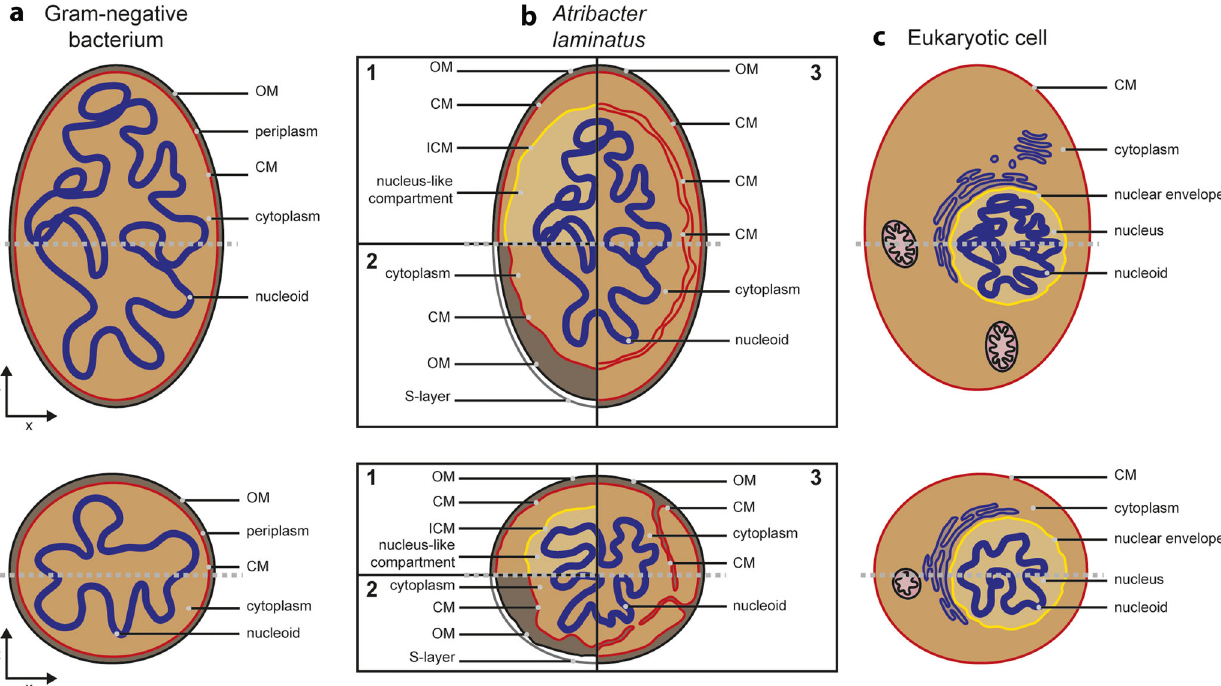
Fig. 1 Alternative interpretations of the cell biology of Atribacter laminatus . Comparison of the cell plans of a typical Gram-negative bacterium ( a ), Atribacter laminatus ( b ), and a typical eukaryotic cell ( c ), displayed both in the xy-plane (top row) and the xz-plane (bottom row). The gray dashed lines indicate the plane illustrated in the other orientation. Shown are three possible interpretations of the cell plan of A. laminatus . In scenario 1, favored by Katayama et al. 9 , A. laminatus has a nucleus-like compartment. Scenario 2 is reminiscent of a typical Gram-negative with an additional S-layer as outer layer. In scenario 3, the cytoplasmic membrane shows extensive invaginations. OM outer membrane, CM cytoplasmic membrane, ICM intra-cytoplasmic